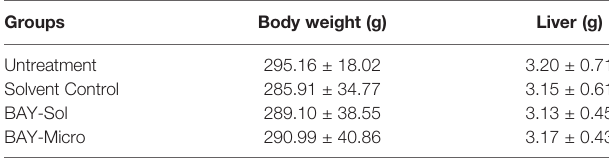
TABLE 3 | The body-weights and liver-weights of rats mentioned in Figure 6 . Groups